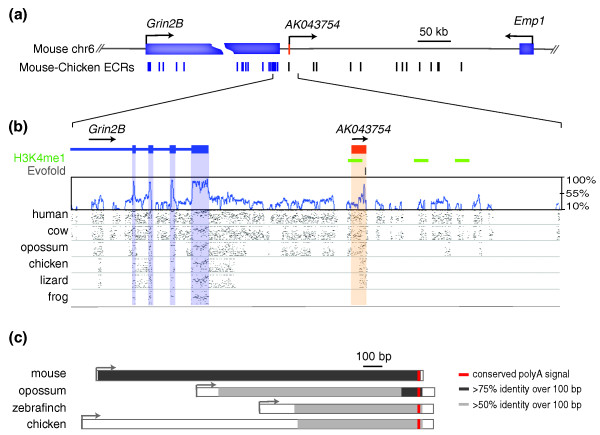
Evolutionary constraint of AK043754. (a) The genomic region of mouse chromosome 6 (chr6) encompassing the lncRNA locus AK043754 (1.7 kb) is depicted. Note the locations of flanking protein-coding genes: Grin2B (glutamate receptor, ionotropic, NMDA2B (N-methyl-D-aspartic acid)) and Emp1 (epithelial membrane protein 1). Also shown are the positions of mouse-chicken ECRs (evolutionarily conserved regions at least 100 bp in size with 70% sequence identity between the mouse and chicken genomes); ECRs within protein-coding regions are shown in blue. (b) A more detailed representation of AK043754 (single exon highlighted in orange) and its immediate flanking regions, including the 3' end of Grin2B. Below the gene structures are the positions of H3K4me1 chromatin marks (green) detected in mouse embryonic stem cells (obtained from UCSC Genome Browser), EvoFold predictions of RNA secondary structures (grey), a SinicView conservation plot [68] based on a 21-vertebrate multispecies sequence alignment (using Threaded Blockset Aligner) generated with mouse as the reference sequence, and Gmaj [66] views of alignments between mouse and the indicated species' sequences (note the detected homology with the orthologous lizard and chicken, but not frog, sequences). (c) Conservation and relative sizes of AK043754 orthologs in various species. The TSSs (arrows) and transcript lengths are depicted in each case. Note the conserved position of a polyA signal (red) and increased sequence conservation (relative to the mouse sequence) towards the 3' end. ECR, evolutionarily conserved region.